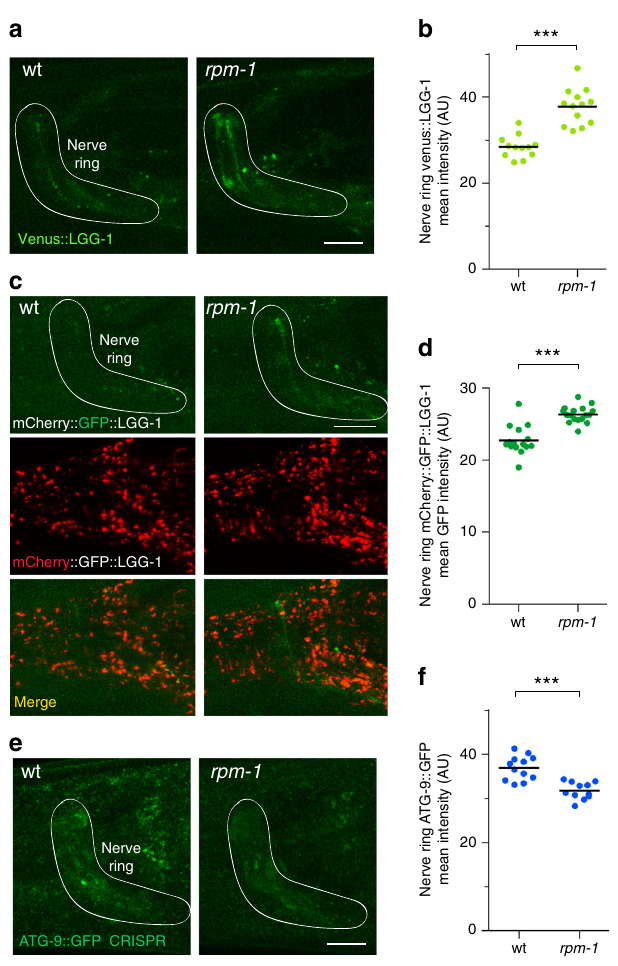
Fig. 8 RPM-1 inhibits autophagosome formation in the nerve ring. a Representative images of Venus::LGG-1/LC3 expressed pan-neuronally using MosSCI. LGG-1 labels autophagosomes in wt and rpm-1 mutants. The nerve ring is highlighted. b Quantitation shows Venus::LGG-1 is increased in the nerve ring of rpm-1 mutants. c Representative images of GFP::mCherry:: LGG-1/LC3 expressed pan-neuronally using MosSCI. GFP signal marks autophagosomes, but is lost in low pH of autolysosomes where only mCherry signal is present. d Quantitation indicates GFP signal from GFP::mCherry::LGG-1 in autophagosomes is increased in the nerve ring of rpm-1 mutants. e Representative images of ATG-9::GFP CRISPR. ATG-9 facilitates membrane recruitment into autophagosomes. Consistent with increased autophagosome formation, there is less ATG-9::GFP in the nerve ring of rpm-1 mutants. f Quantitation shows ATG-9::GFP CRISPR is reduced in the nerve ring of rpm-1 mutants. For b, d and f , means are shown from 12 or more animals imaged during three independent experiments for each genotype. Signi fi cance determined using Student ’ s t test with Bonferroni correction. *** p < 0.001. Scale bars 10 μ M. Source data are provided as